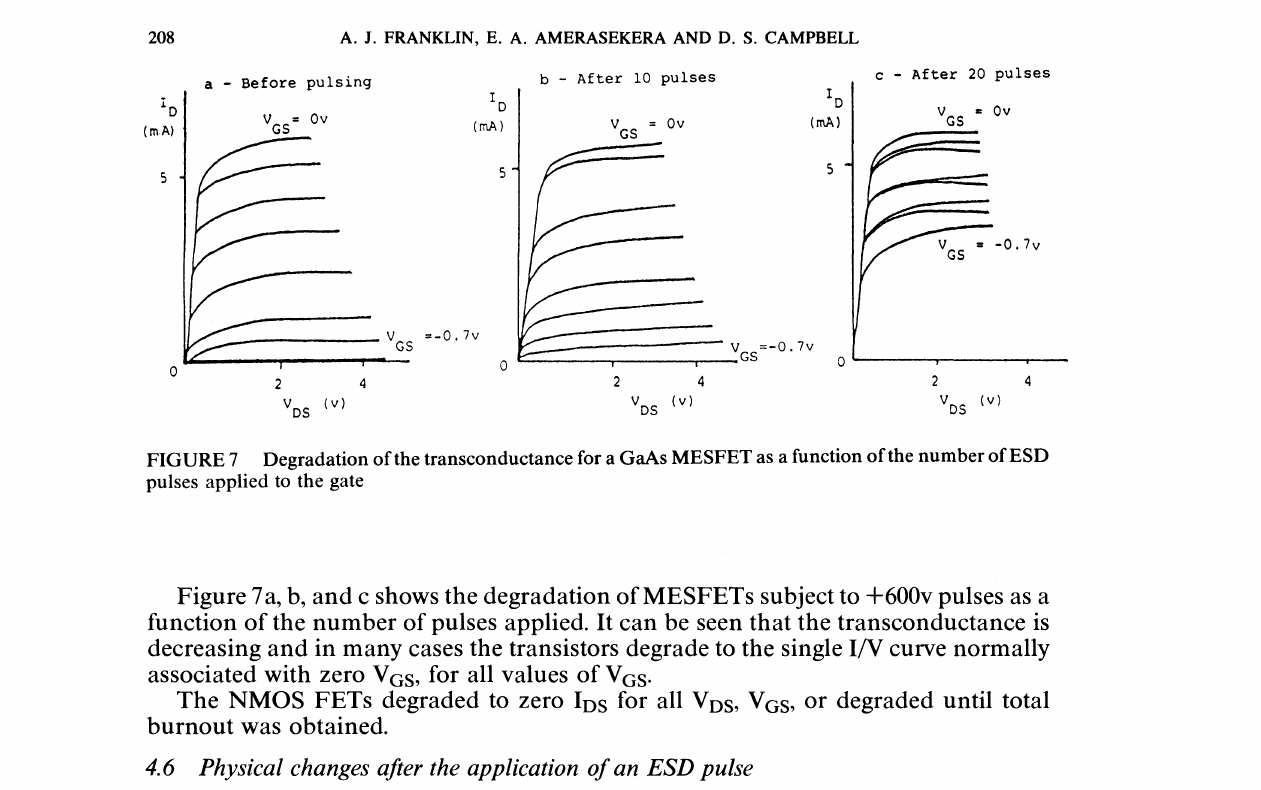
Figure 7a, b, and c shows the degradation of MESFETs subject to +600v pulses as a function of the number of pulses applied. It can be seen that the transconductance is decreasing and in many cases the transistors degrade to the single I/V curve normally associated with zero VGs, for all values of